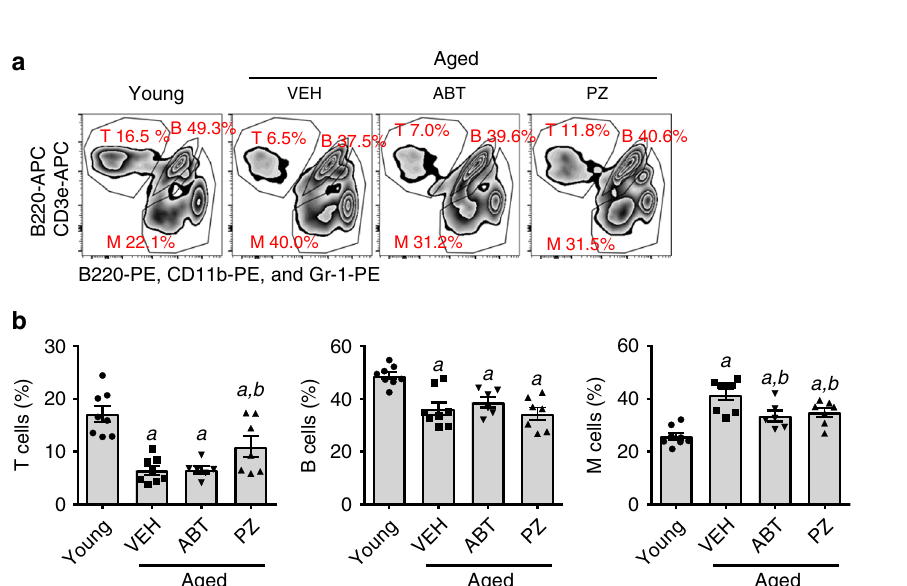
aged mice treated with VEH, ABT or PZ by Alizarin Red staining. Representative staining images (left) and quanti fi cation of Alizarin Red staining in the cells (right) are presented. j , k . Analysis of adipogenesis of BM stromal cells from young (Young) or naturally aged mice treated with VEH, ABT or PZ by Oil Red O staining. Representative staining images (left) and quanti fi cation of Oil Red O staining in the cells (right) are presented. l , m . Analysis of osteoclastogenesis of BM myeloid cells from young (Young) or naturally aged mice treated with VEH, ABT, or PZ by tartrate-resistant acid phosphatase (TRAP) staining. Representative images (left) and quanti fi cation of TRAP-positive multinucleated osteoclasts (right) are presented. The data are presented as mean ± SEM ( a – e , n = 3 independent assays; g , n = 5 independent assays; i , k , and m , n = 4 independent assays; each assay using a sample pooled from 2 to 3 mice from the same experimental group). a , b , c p < 0.05 vs. Young, Aged + VEH, and Aged + ABT, respectively, determined by one-way ANOVA with Tukey ’ s post-hoc tests. Scale bars for f , h , j , and l are 50 µ m, 1 cm, 50 µ m, and 500 µ m, respectively. Source data are provided as a Source Data fi le. The exact P values are provided in the Source Data fi le.